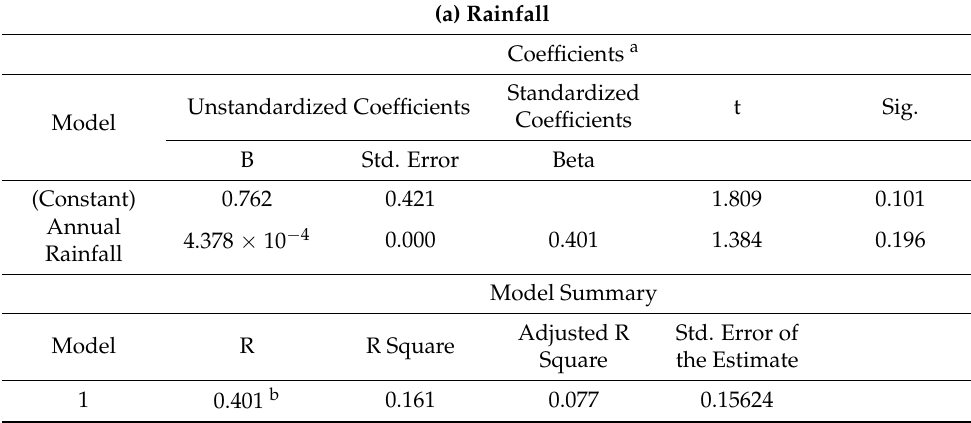
Table 2. Regression analysis of rainfall and temperature against maize